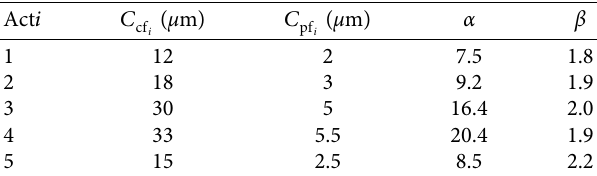
Figure 7: Comparative scheme between both models with e � 0%. (a) Base case. (b) Current case. Table 4: Parameters associated with the quantifcation of risk in the case of current